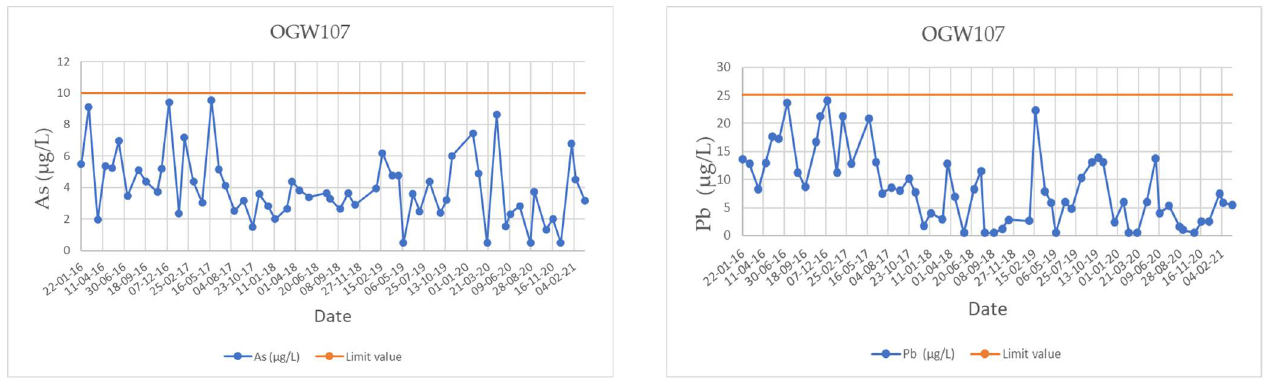
Figure 9. As and Pb in ground waters vs. time 250 m downstream from the old Olympias arsenopyrites concentrate storage area (OGW107 monitoring station).